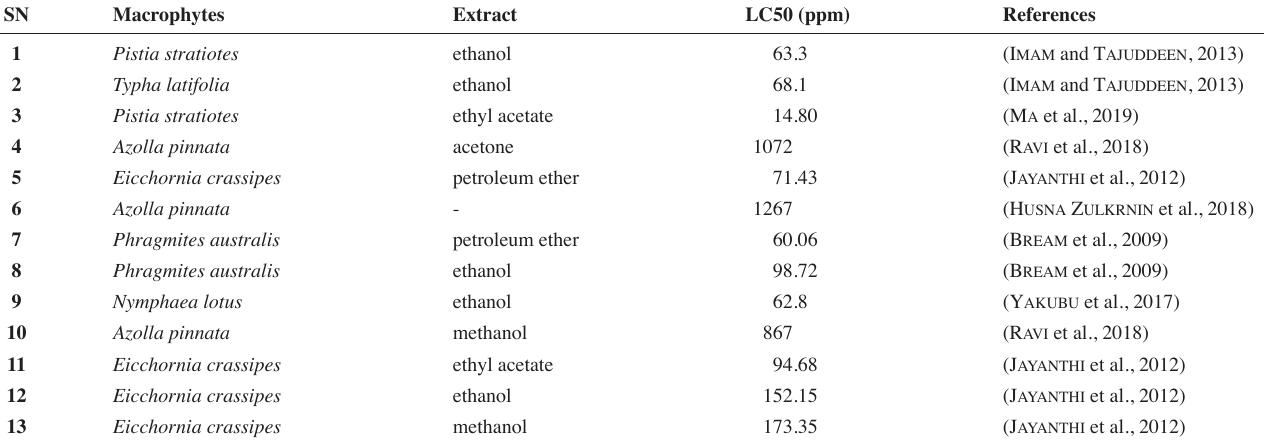
Tab. 3: Larvicidal efficacies of aquatic macrophytes leaves